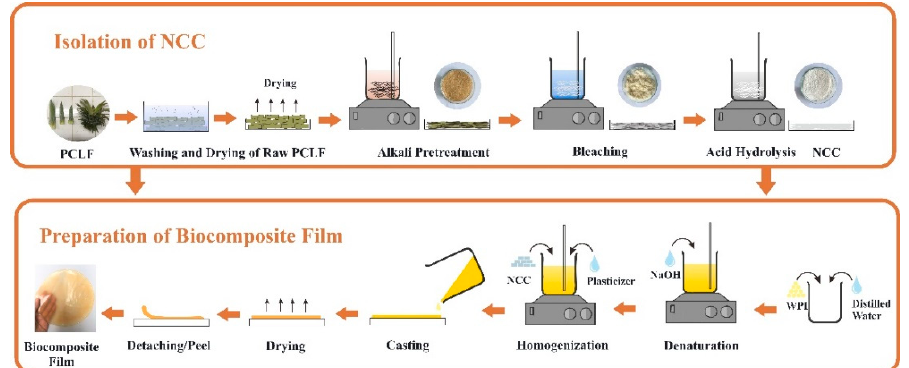
Figure 1. Schematic description of biocomposite film preparation.